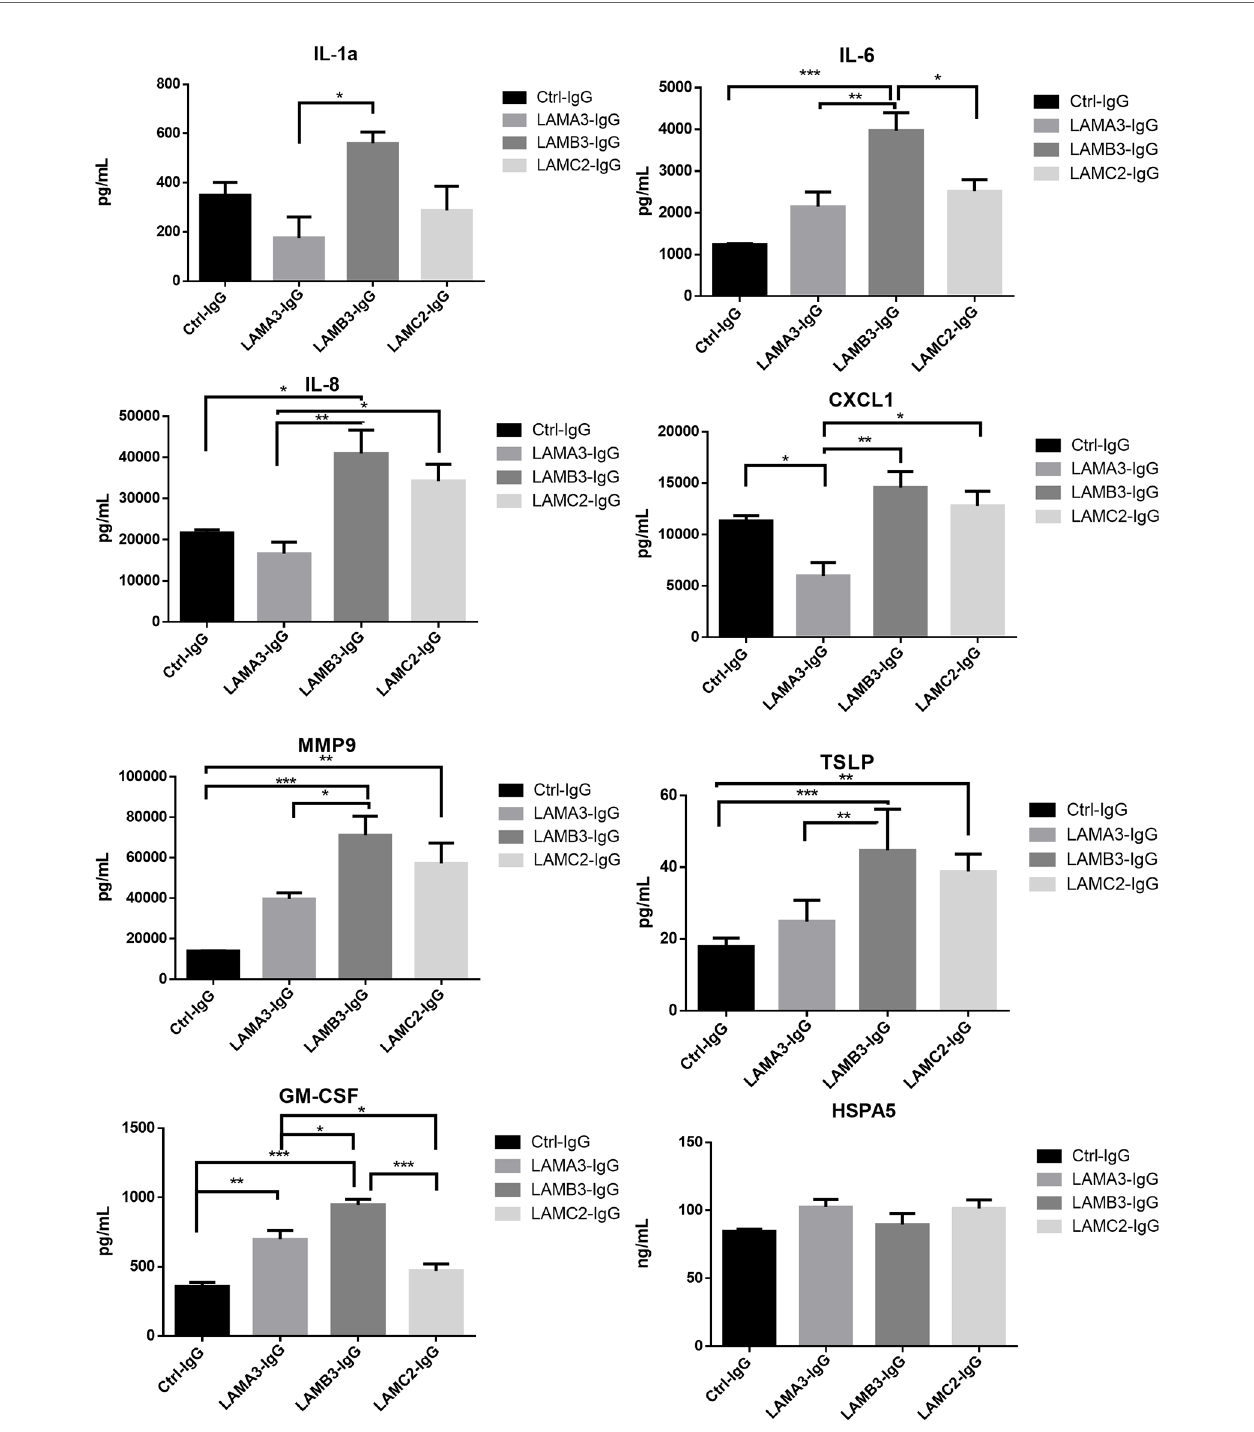
FIGURE 3 | Primary human keratinocytes were treated for 24 hours with 3.5 m g/ m L of IgG from patients with laminin-332 pemphigoid with autoreactivity against either laminin a 3 (n=4-5), laminin b 3 (n=4), laminin g 2 (n=4-5), or control (n=4). Luminex and ELISA assays were performed to quantify supernatant protein expression. Bar charts demonstrate signi fi cant upregulation of IL-1a, IL-6, IL-8, CXCL1, MMP9, TSLP, and GM-CSF by one way ANOVA (P < 0.05). Bars indicate Tukey ’ s test for multiple comparisons between groups (*P <0.05, **P < 0.01, ***P < 0.001). HSPA5 levels did not signi fi cantly differ. Values shown are for a single